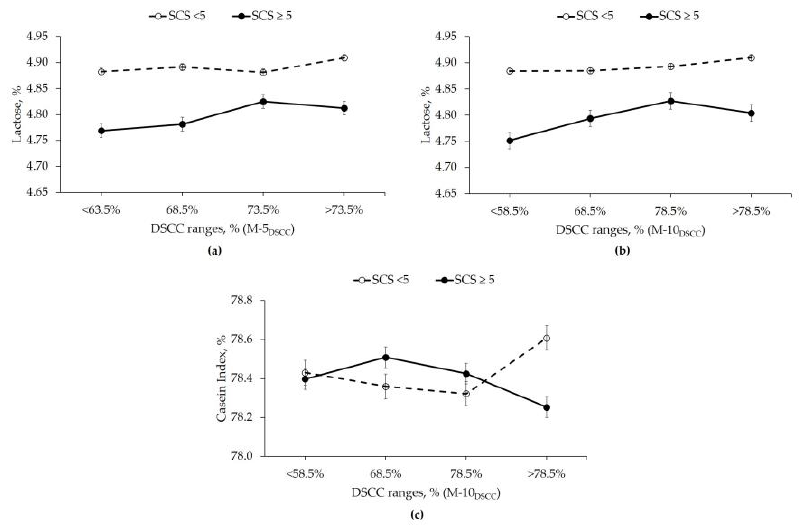
Figure 1. Effect of interaction of SCS×DSCC according to M-5 DSCC model on lactose ( a ) ( p < 0.01), and SCS × DSCC according to M-10 DSCC model on lactose ( b ) ( p < 0.001) and casein index ( c ) ( p < 0.05). Polymorphonuclear leukocytes have different enzyme profiles with different activity of